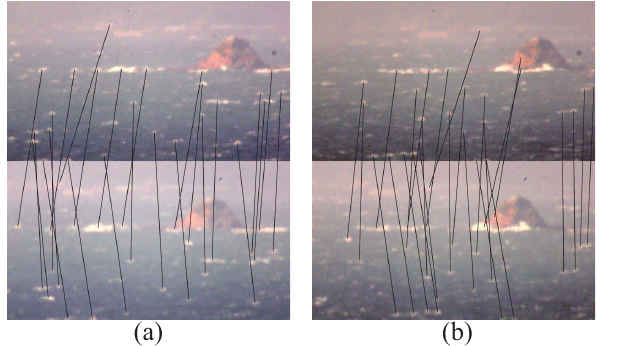
Figure 4. Final established decision tree.